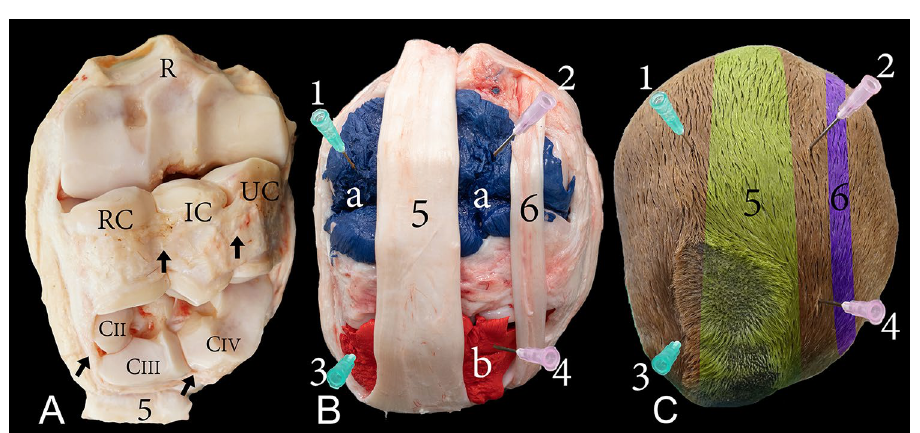
Figure 7. Dorsal view of a left carpal joint providing orientation for the arthrocentesis approaches through three different types of specimens: ( A ) bones, ( B ) dissected, and ( C ) intact. R, the distal end of the radius; RC, radiocarpal bone; IC, intermediate carpal bone; UC, ulna carpal bone; CII, carpal bone II; CIII, carpal bone III; CIV, carpal bone IV; a, radiocarpal joint cavity; b, intercarpal joint cavity; 1, the dorsal medial approach of radiocarpal joint; 2, the dorsal lateral approach of the radiocarpal joint; 3, the dorsal medial approach of the intercarpal joint; 4, the dorsal lateral approach of the intercarpal joint; 5, Extensor carpi radialis tendon; 6, common digital extensor